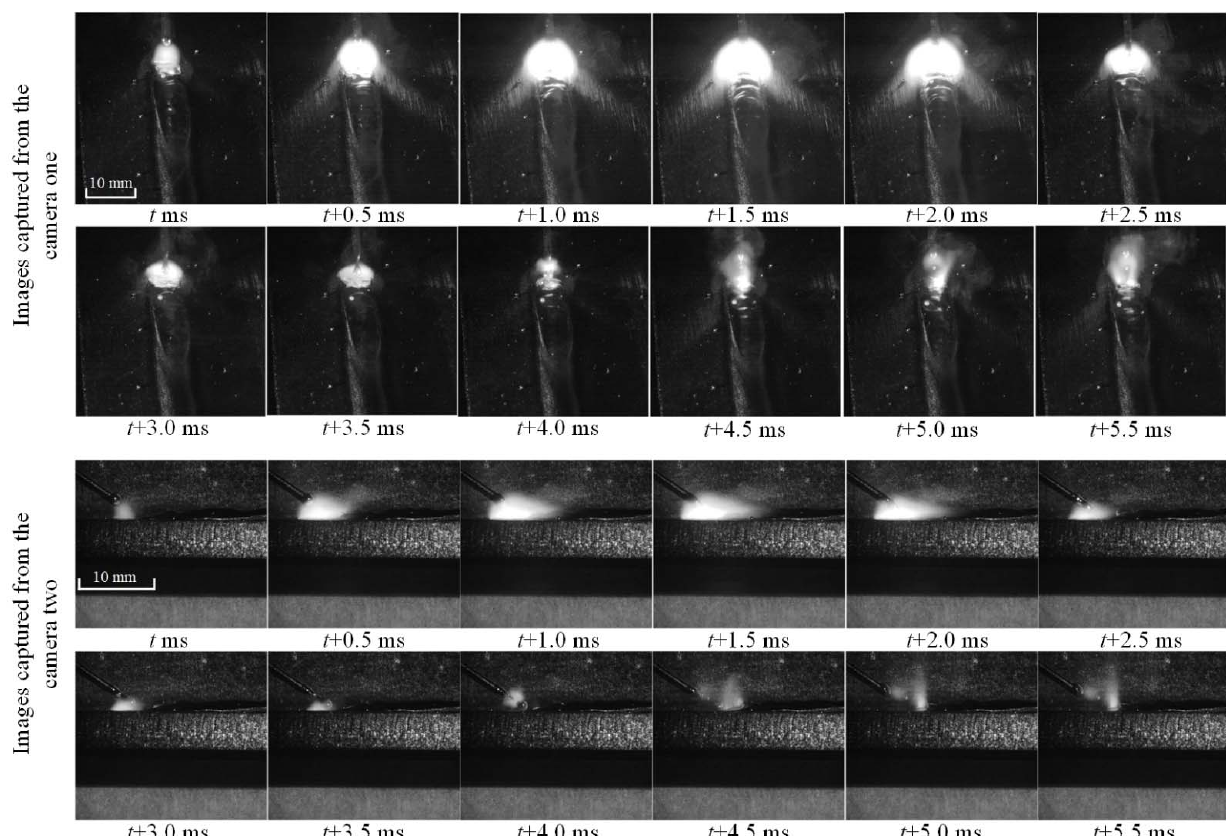
Figure 5. Visual phenomena of non ‐ penetration (No.1) in laser ‐ MIG hybrid welding.